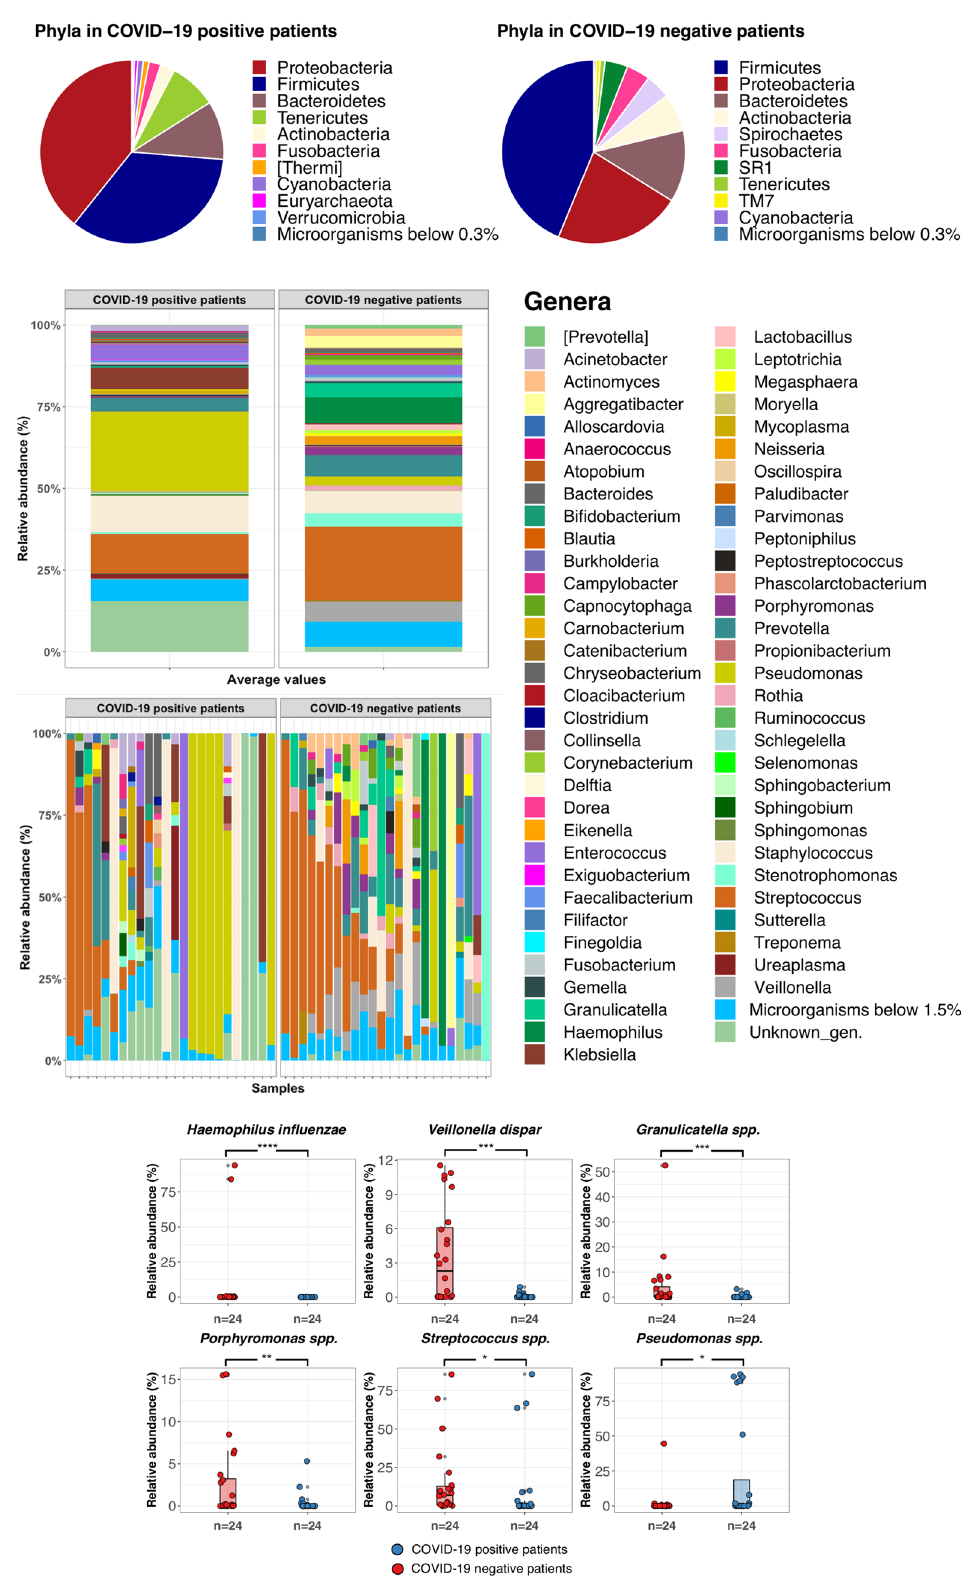
Figure 2. Taxonomic profiles at the phylum (pie charts) and genus level (stacked barplot) of COVID-19 critically ill patients and negative subjects. Taxa that were present in significantly different relative abundances after SIMPER analysis are shown in the lower